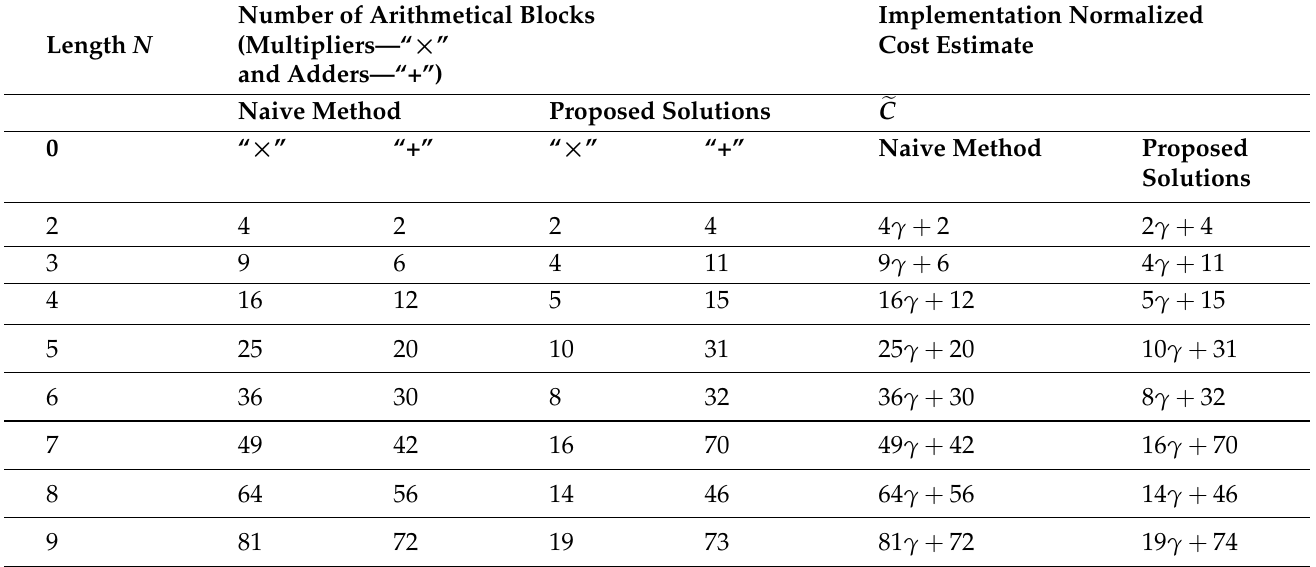
Table 1. Comparative estimates of the number of hardwired multipliers and adders for the case of completely parallel implementations of the naive-method-based solutions and of the proposed solutions.